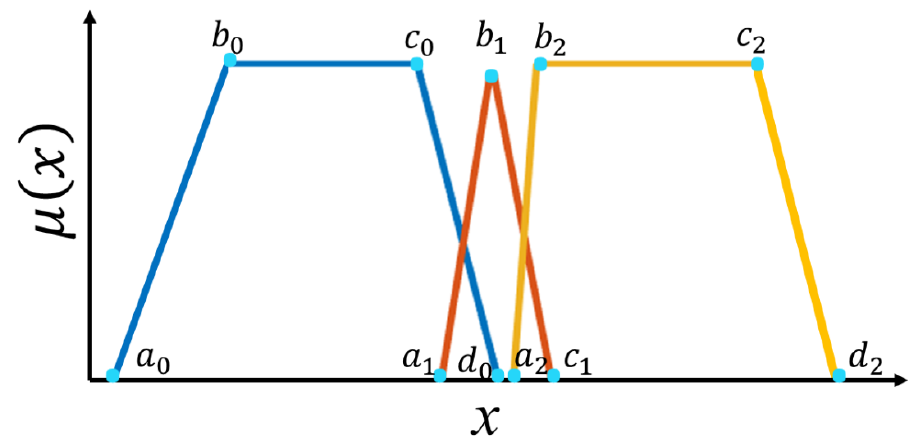
Figure 8. Points membership functions of Input 1 and Input 2.